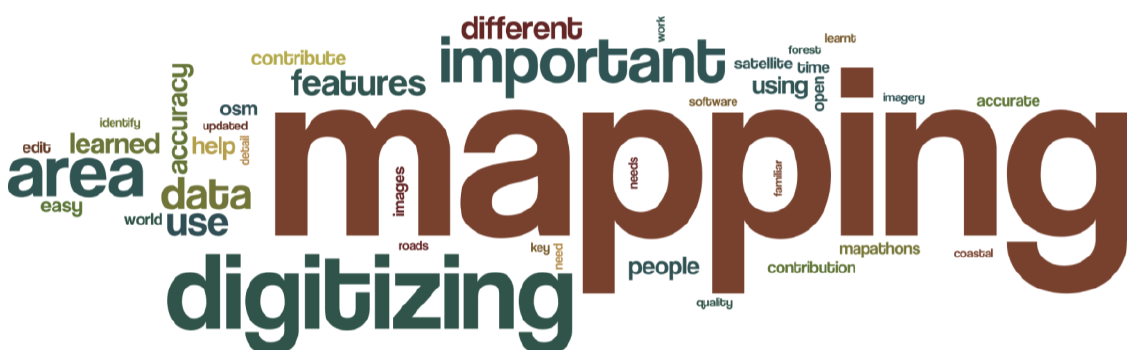
Figure 6. A word cloud on what participants indicated they learnt during the mapathon (created using